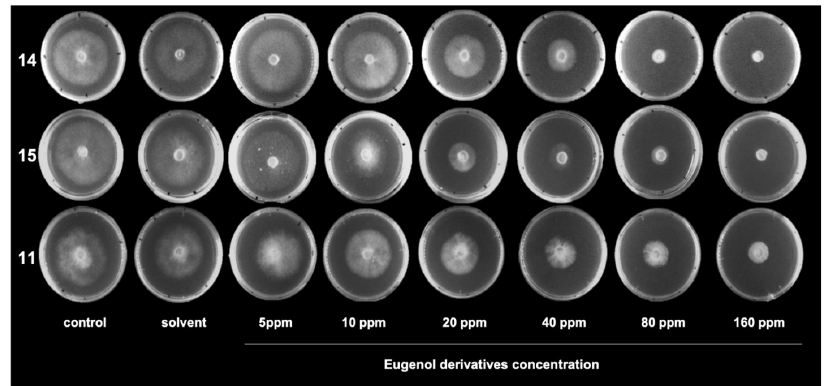
Figure 4. Effect of eugenol derivatives on hyphae growth of Botrytis cinerea in solid media. Photographs of hyphal growth of B. cinerea in the absence and presence of different concentrations of 11 , 14 and 15 after 48 h of incubation.